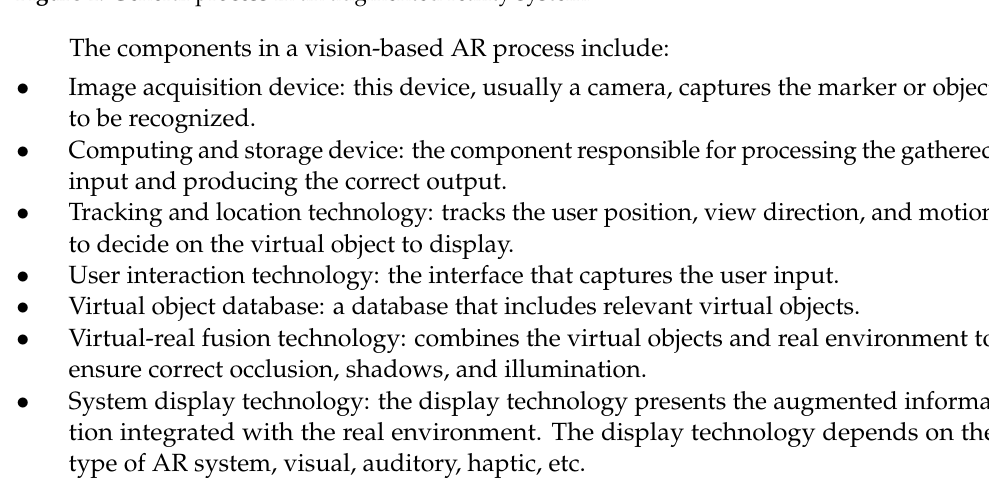
Figure 1. General process in an augmented reality system .